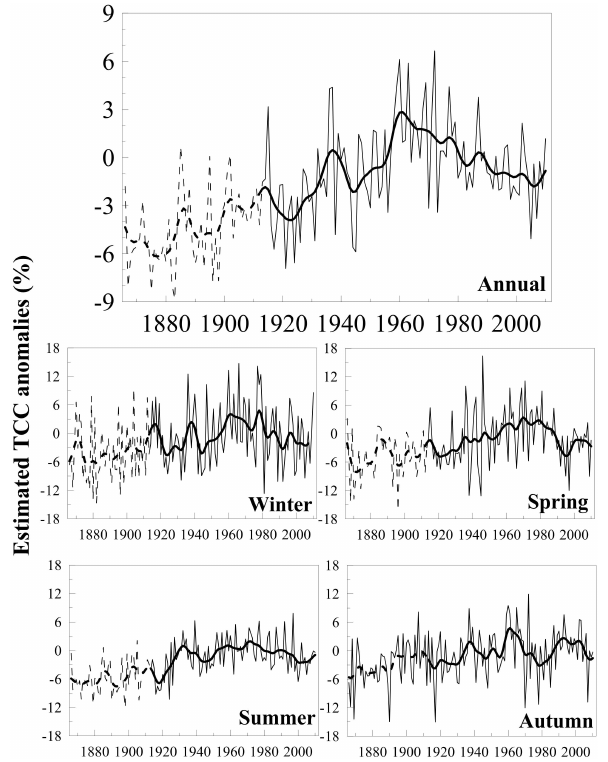
Fig. 5. Mean annual and seasonal estimated TCC (%) series (thin lines) from 1866 to 2010 in Spain, plotted together with a 13-year Gaussian low-pass filter (thick line). The series are expressed as anomalies from the 1971–2000 mean. Dashed lines are used before 1913 to indicate the lower number of series available before this year.